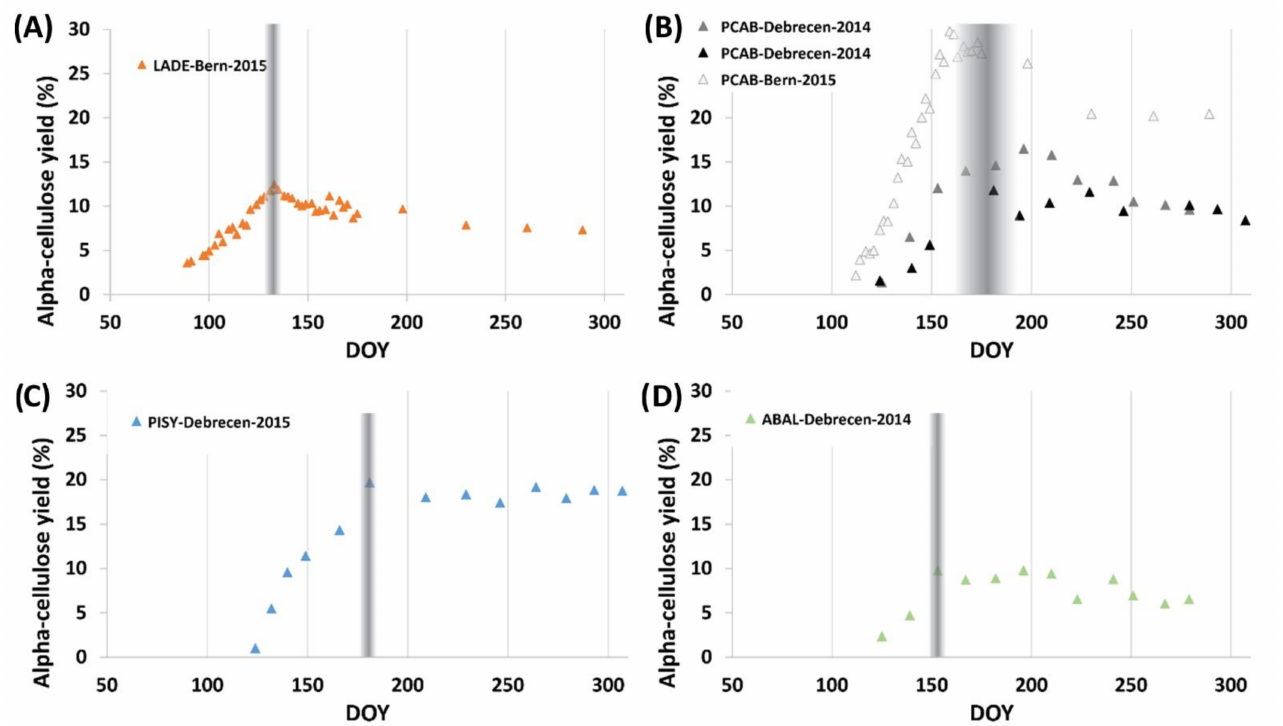
Figure 2. Seasonal distribution of alpha-cellulose yields of leaf samples of four needle species. ( A ) European larch ( Larix decidua Mill.), ( B ) Norway spruce ( Picea abies (L.) Karst.), ( C ) Scots pine ( Pinus sylvestris L.), ( D ) Silver fir ( Abies alba Mill.) Ordinate and abscissa represent the alpha-cellulose yields in percentage and the Day of Year (DOY), respectively. The gray shading indicates the transition from the juvenile to the mature phase. In the case of Norway spruce ( B ) the wider shading covers the transition period of all